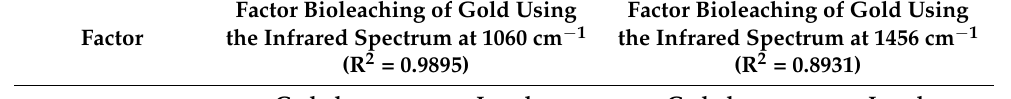
Table 4. Optimal values of the studied factors, according to the 2 5 − 2 fractional factorial design of